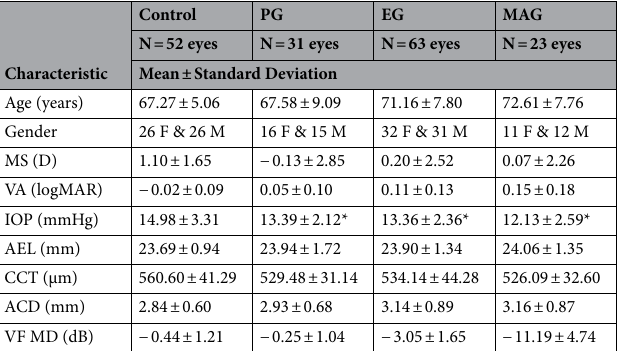
Table 1. Participant demographics for glaucoma participants and age-matched controls. MS = mean sphere, VA = visual acuity, IOP = intraocular pressure, AEL = axial eye length, CCT = central corneal thickness, ACD = anterior chamber depth, VF MD = visual field Mean Deviation. *Note that POAG IOP represents treated